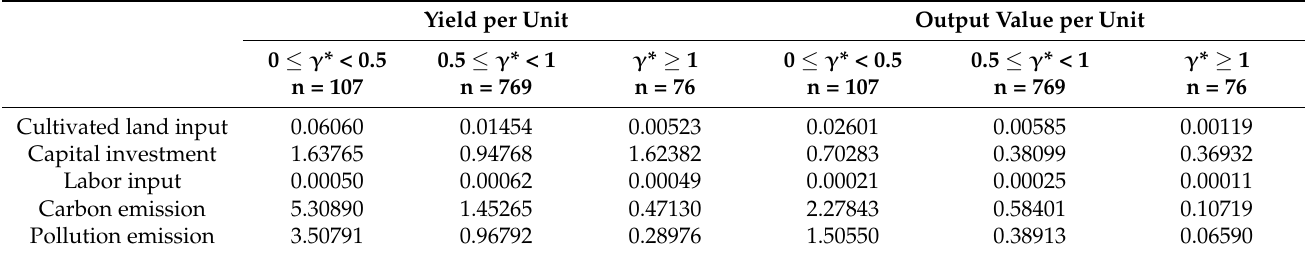
Table 3. Input and undesired output of yield per unit and output value per unit (mean).